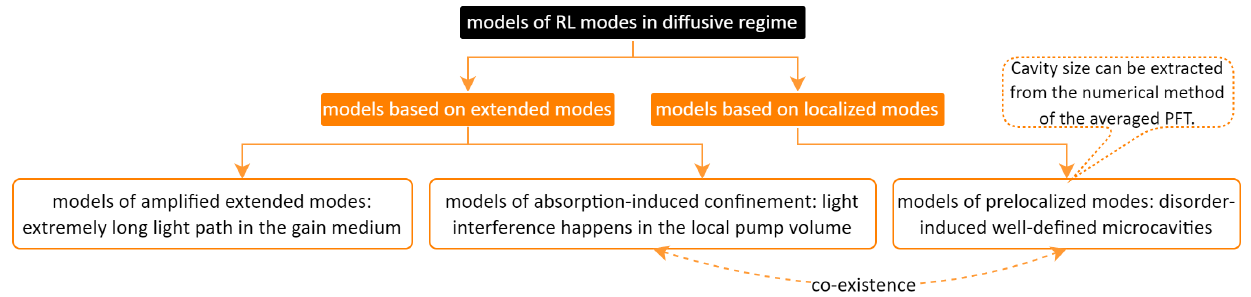
Figure 2. Summary of the models of RL spatial modes in the light diffusive